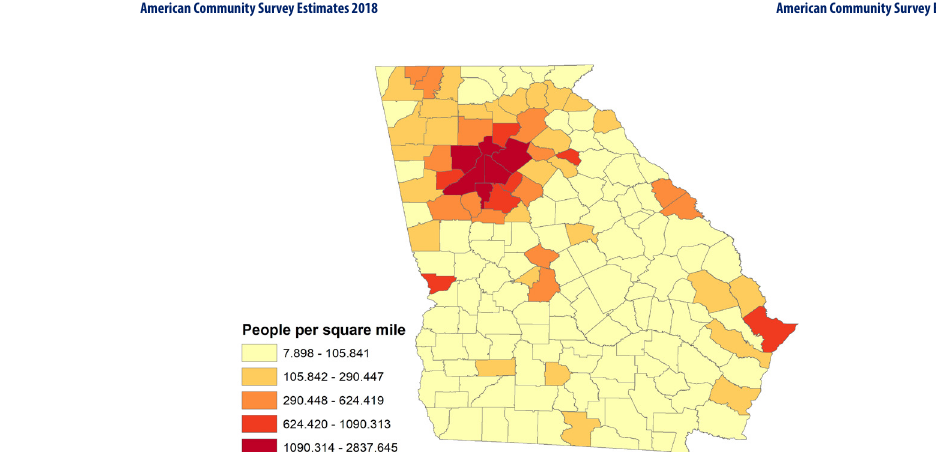
Figure 3: Proportion of County Population that is Uninsured in Georgia, American Community Survey Estimates 2018